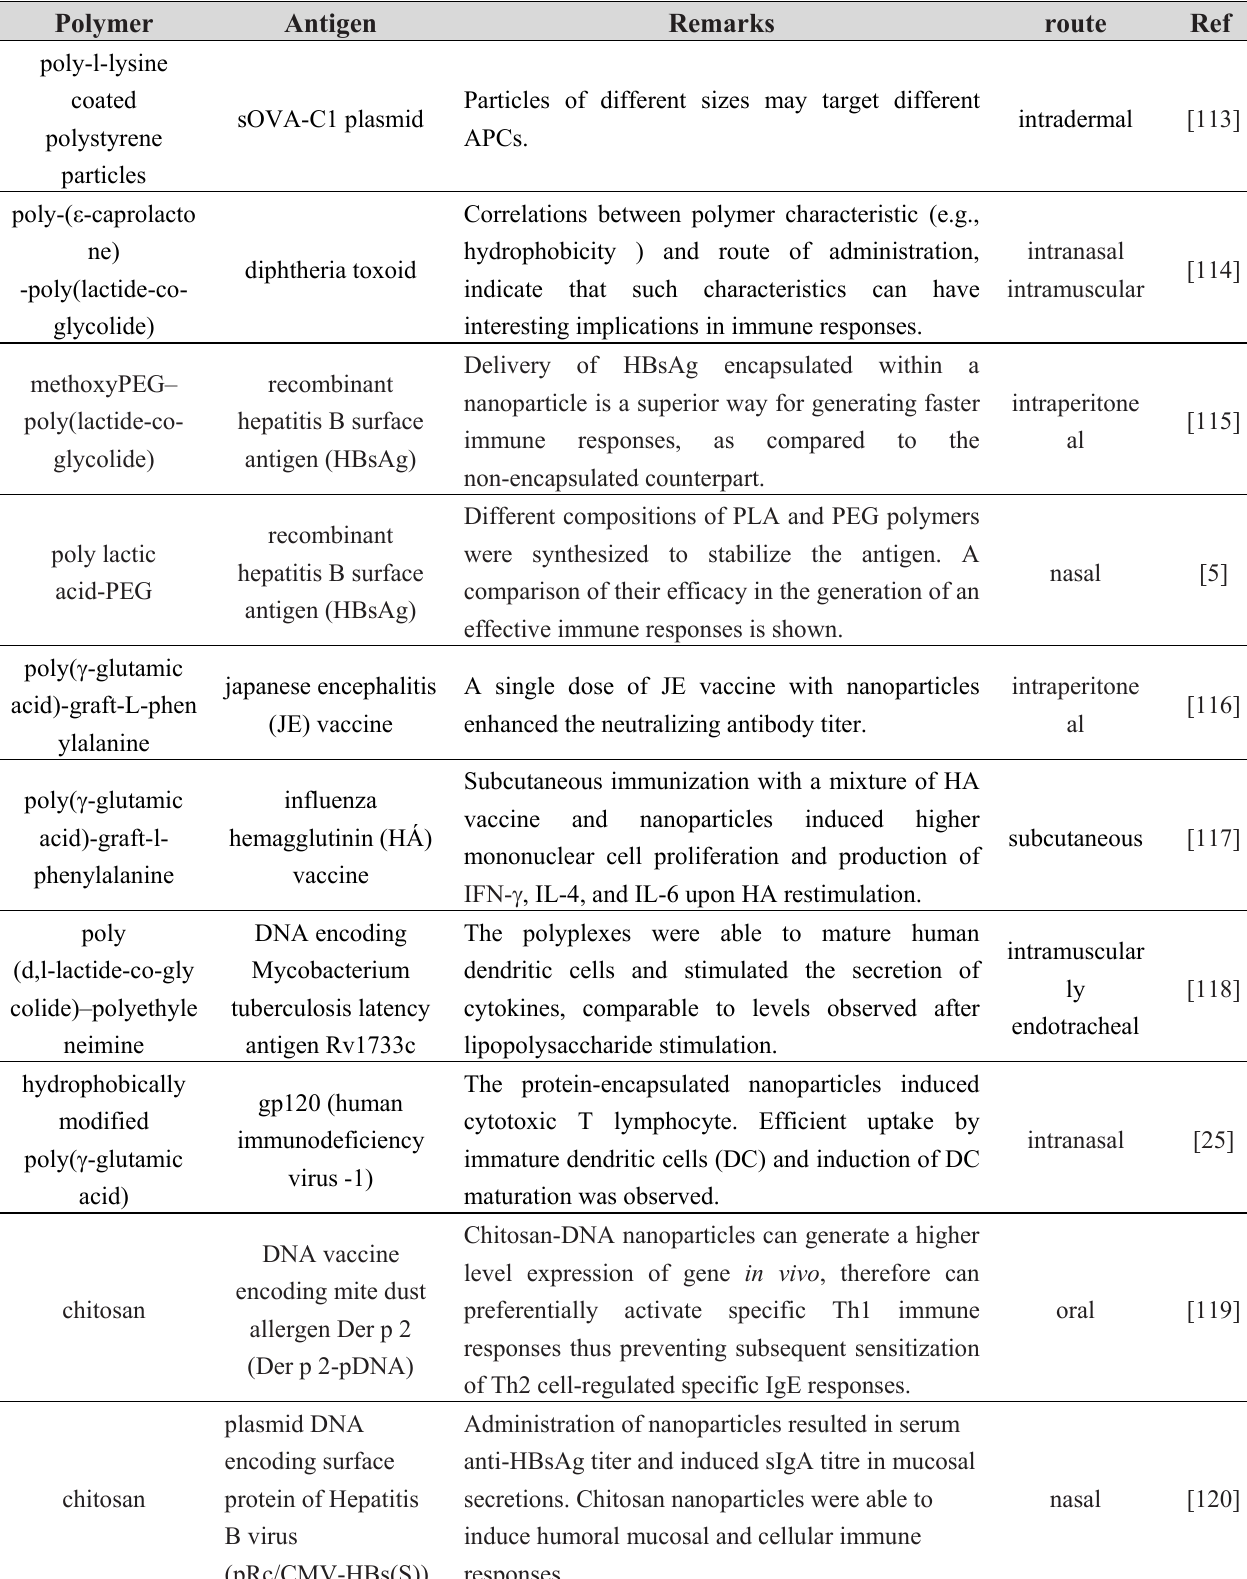
Table 2. Polymeric nanoparticles for vaccine